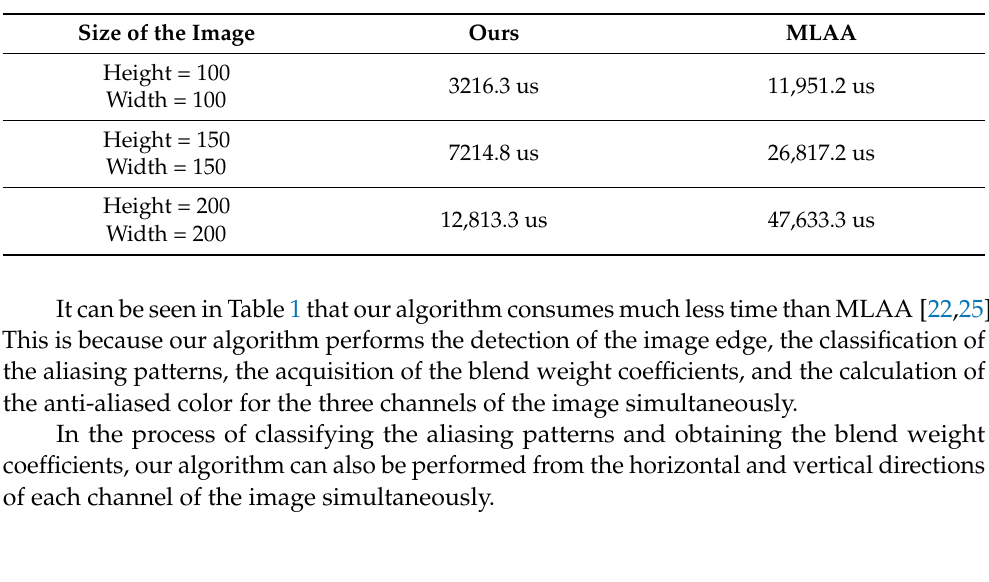
Table 1. Timing performance of the two algorithms.